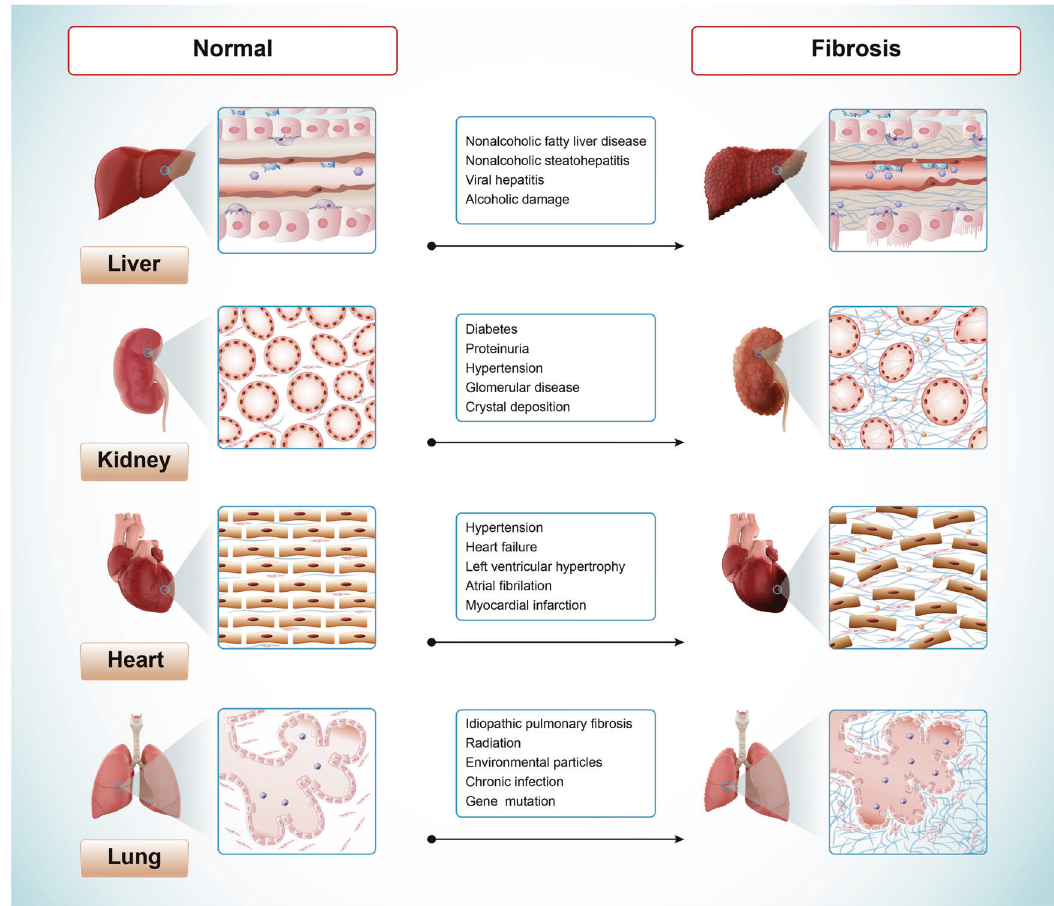
Fig. 1 The aetiology of fi brosis in different tissues or